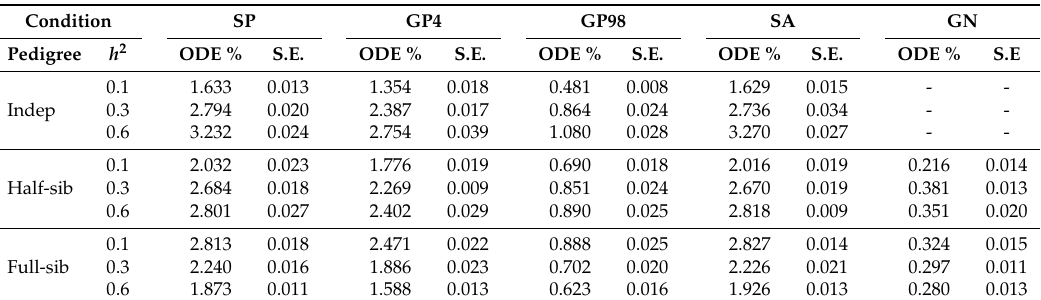
Table 3. Average ODEs reported together with standard errors (S.E.) for simple pairwise (SP), greedy pairwise (GP4 and GP98), simulated annealing (SA) and genetic neighborhood (GN) procedures for Ω ( 196 ) RCB designs at a spatial correlation of 0.6. A